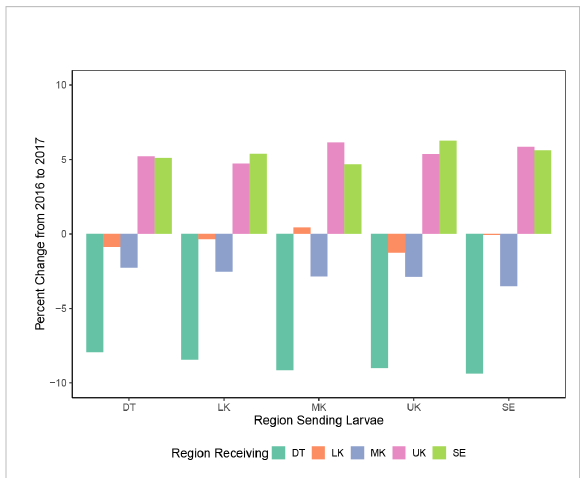
FIGURE 4 The percent change in the proportion of larvae exchanged between each region from 2016 to 2017. Each region of Florida ’ s Coral Reef is denoted by a different color: Dry Tortugas (DT) teal; Lower Keys (LK) in orange; Middle Keys (MK) blue; Upper Keys (UK) pink; Southeast (SE) lime green. DT, LK, and MK all received a smaller proportion of larvae in 2017, while UK and SE received a greater proportion of larvae in 2017 than in